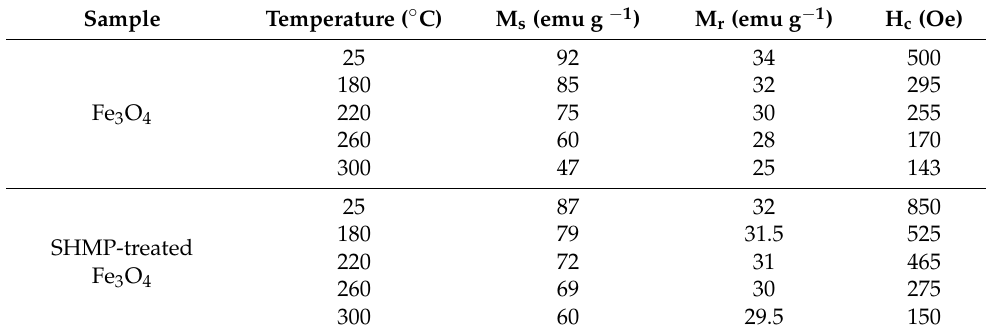
Table 4. Parameters obtained from VSM measurement for Fe 3 O 4 and treated Fe 3 O 4 samples at their ambient (25 ◦ C) and different calcined